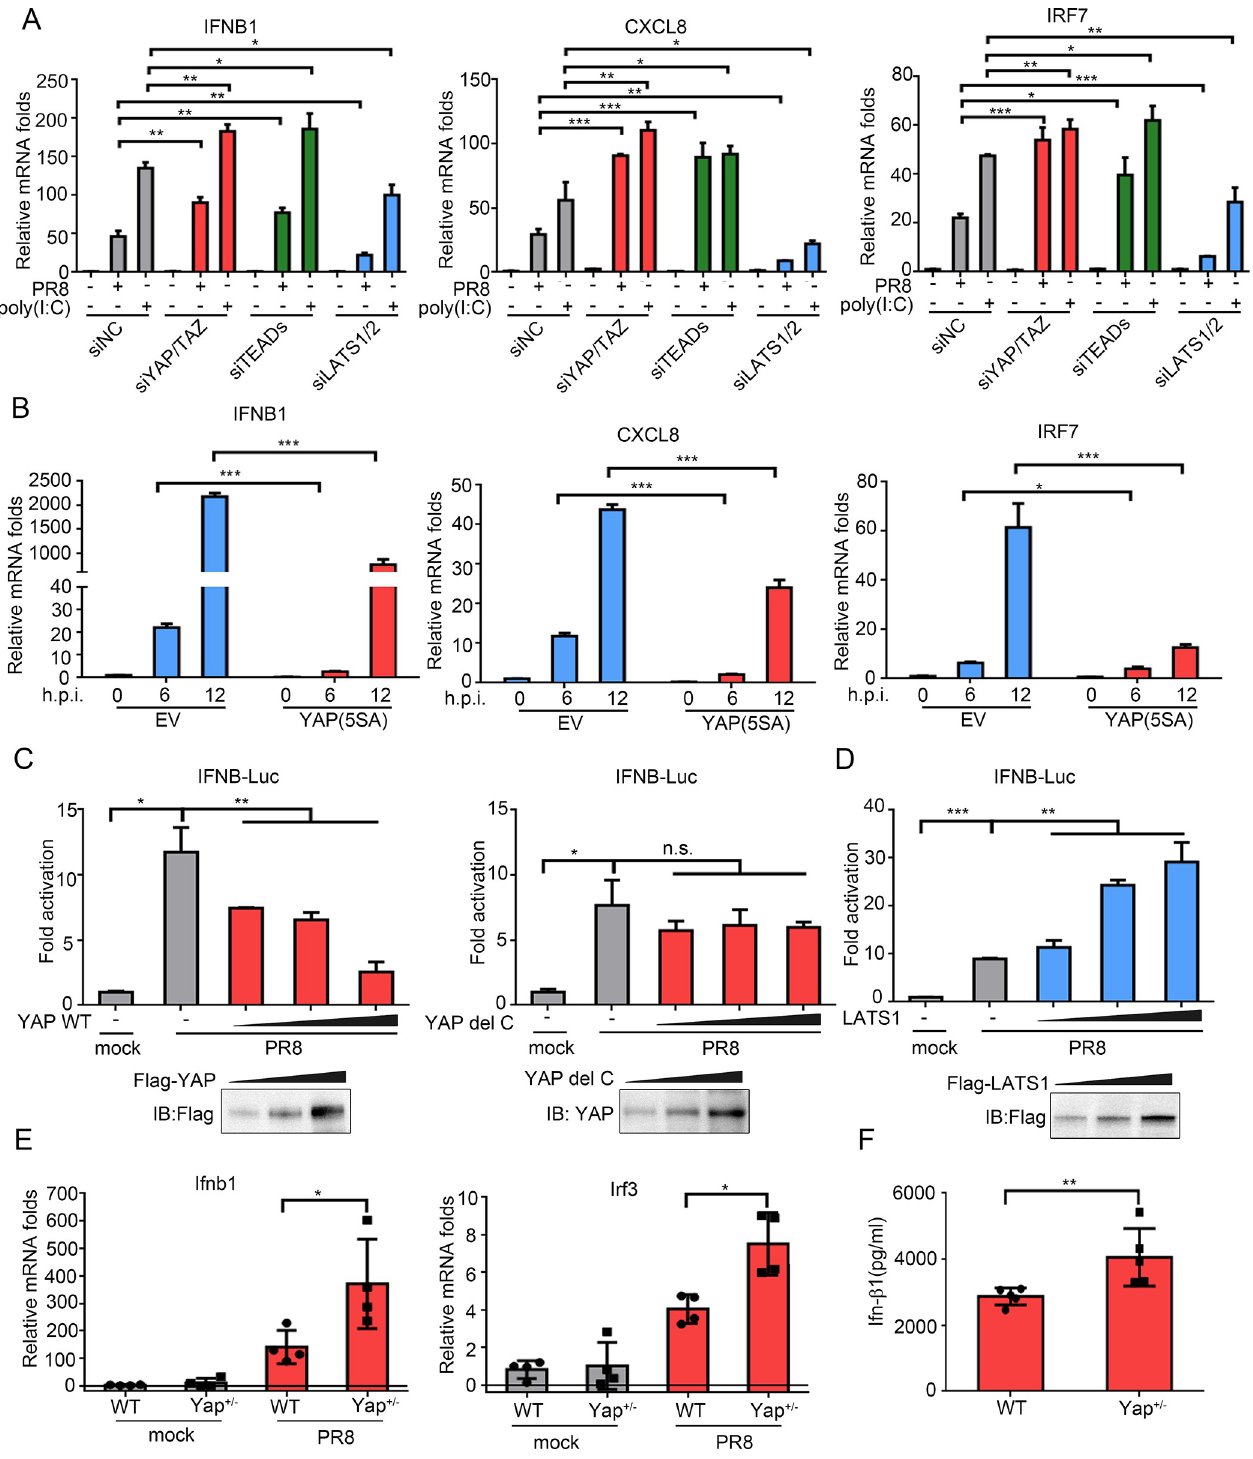
Fig 4. Host innate immune response to IAV is regulated by YAP/TAZ. (A, B) IFNB1, CXCL8, and IRF7 transcript levels were assessed by RT-qPCR in A549 cells with NC, YAP/TAZ, LATS1/2 and TEADs knockdown (A), or YAP(5SA) overexpression (B). Afterwards, cells were stimulated with PR8 virus or poly I:C. (C, D) The IFNB promoter activity in A549 cells co-transfected with different concentrations of YAP, YAP del C (C) or LATS1 (D) plasmids upon PR8 virus infection was measured by dual-luciferase assay. (E) Changes in mRNA expression of mouse Ifnb1 and Irf3 were assessed in the lungs of WT and Yap +/- mice (n = 4 per group) upon PR8 virus infection or corresponding mock controls. (F) Level of Ifn- β 1 was assessed by ELISA in the lung tissues of WT